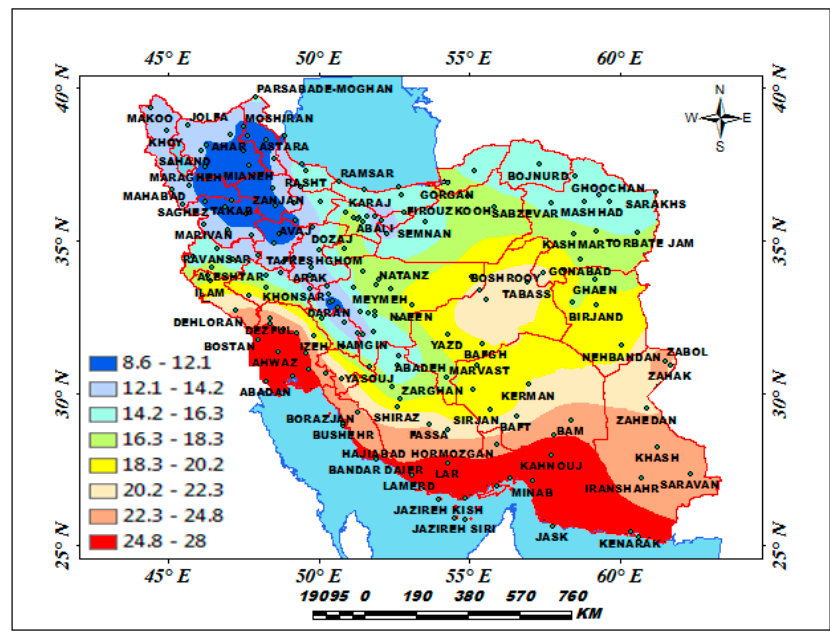
Figure 3. Distribution of annual temperature.